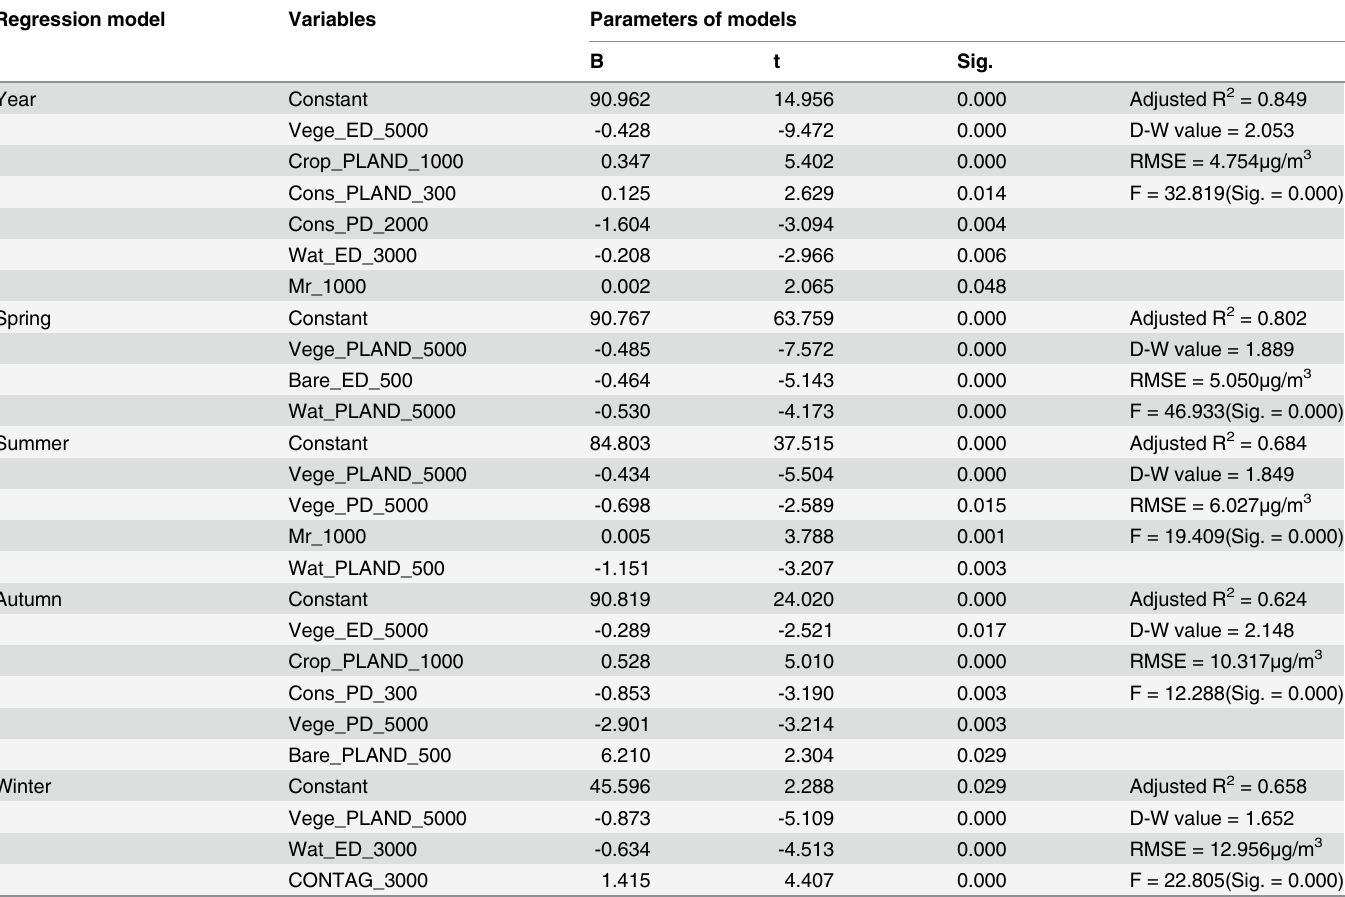
Table 4. Analysis of coefficient of regression